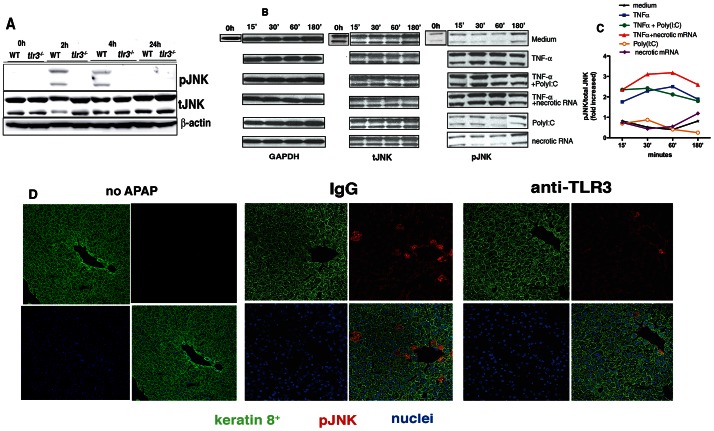
TLR3 regulates JNK activation.(A) Phosphorylation of JNK in liver samples was measured after APAP. Liver lysates of WT and tlr3
−/− mice or (B) NmuLi were analyzed and the immunoblots shown are representative of three independent experiments while the immunoblots from 30′ time point are representative of four independent experiments. (C) The data in (B) were quantified by densitometry analysis using Image J Software. (D) Confocal analysis indicating the expression of p-JNK (red) and Keratin 8+ (green) in hepatocytes from WT mice that did not receive APAP (control), and that received either rabbit IgG or anti-TLR3 polyclonal antibody 3 h after APAP injection. DAPI stained the nuclei (blue). Tissues were collected 4 h post APAP injection. Representative images at 400x are shown (n = 5 per group).